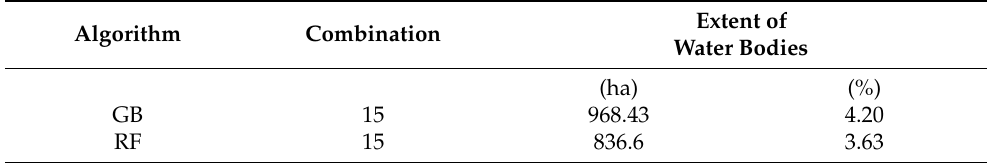
Table 8. Extent of water bodies identified by the two algorithms for the dry season.